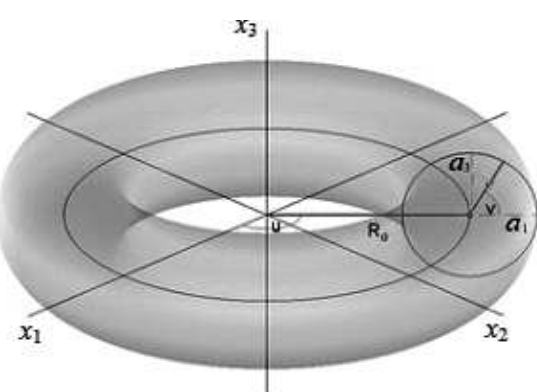
Fig. 1. Circular torus with an elliptical cross-section of the